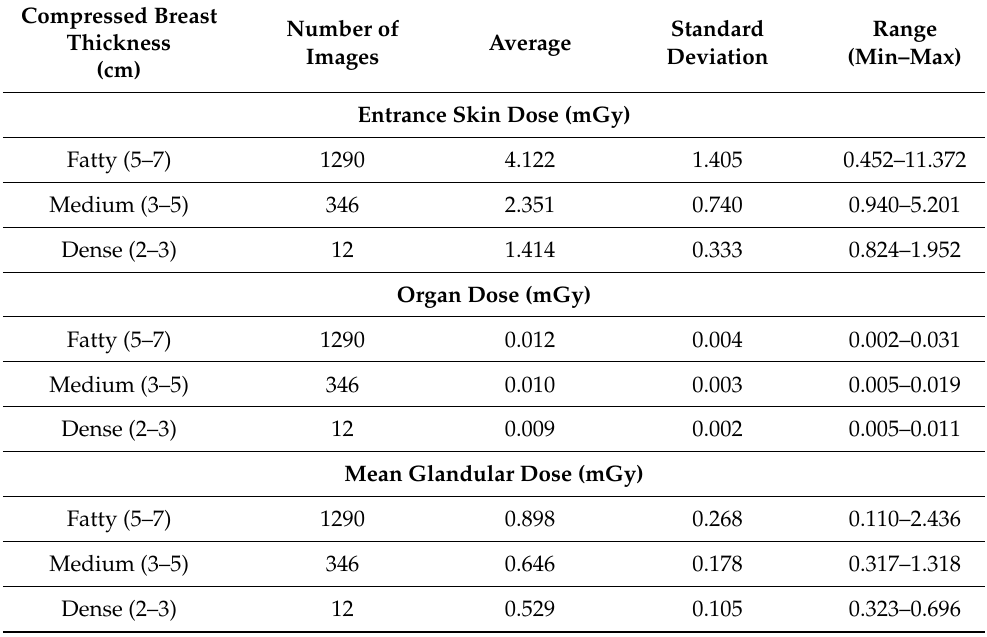
Table 2. Descriptive summary of entrance skin dose (ESD), organ dose (OD), and mean glandular dose (MGD) based on breast